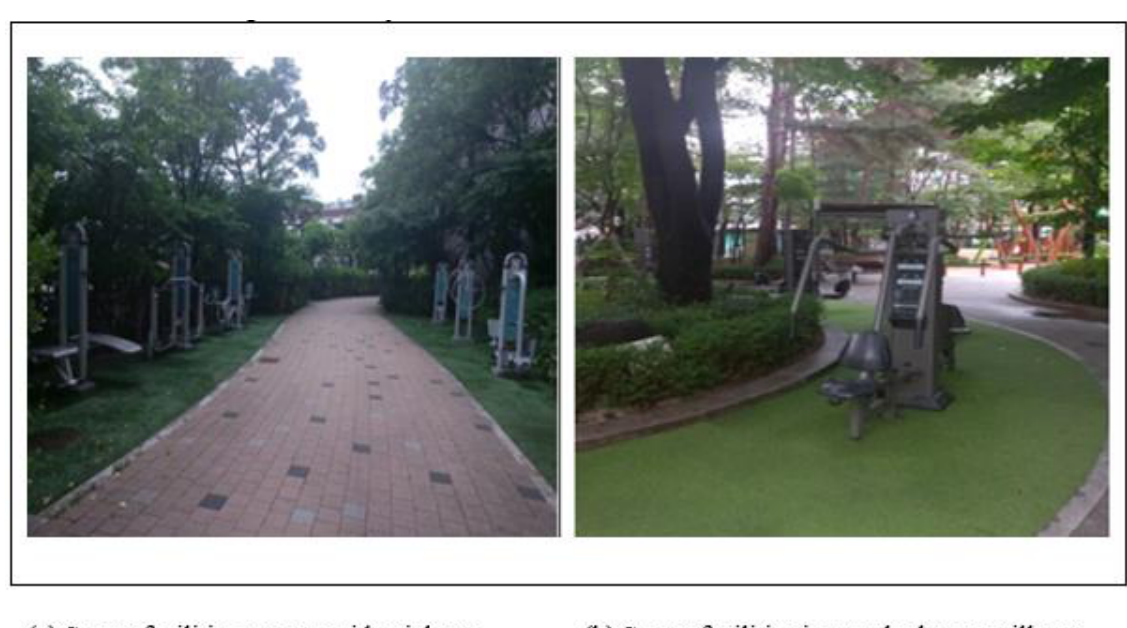
Figure 2. Neighborhood sports facilities. In Korea, neighborhood sports facilities are mainly located near residential areas ( a ) or in parks close to villages ( b ).